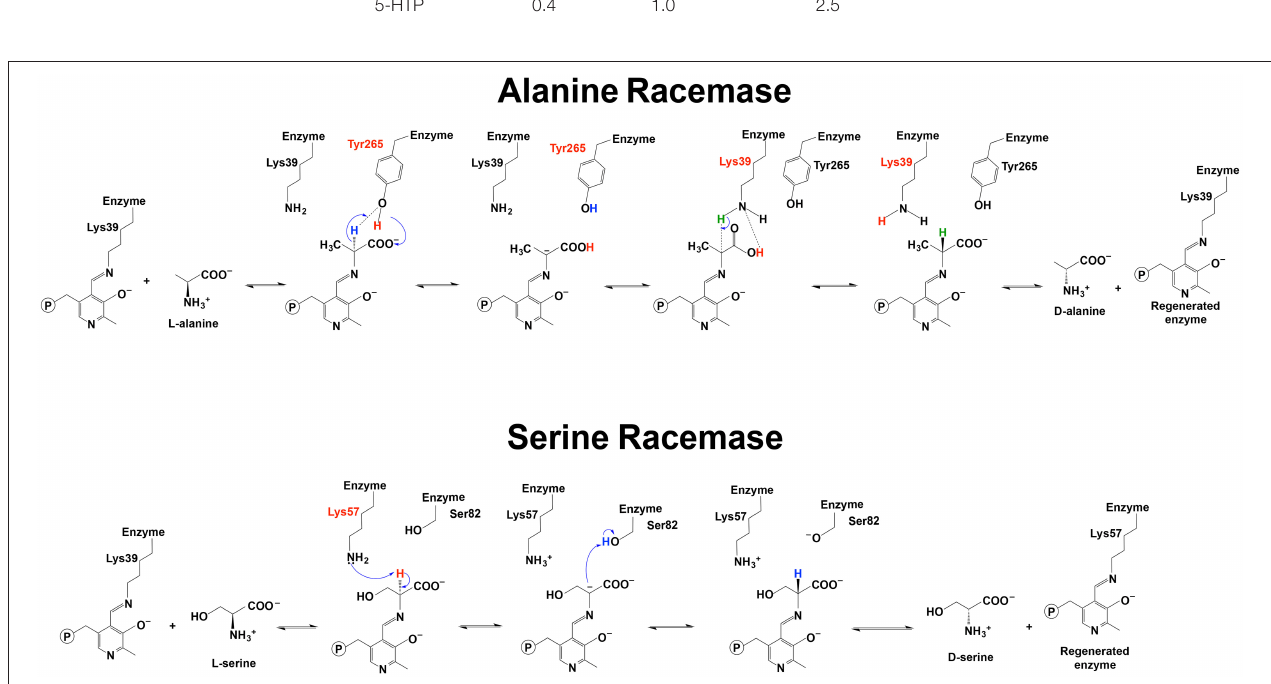
stearothermophilus alanine racemase generated new aldolase activity while the racemization activity was largely